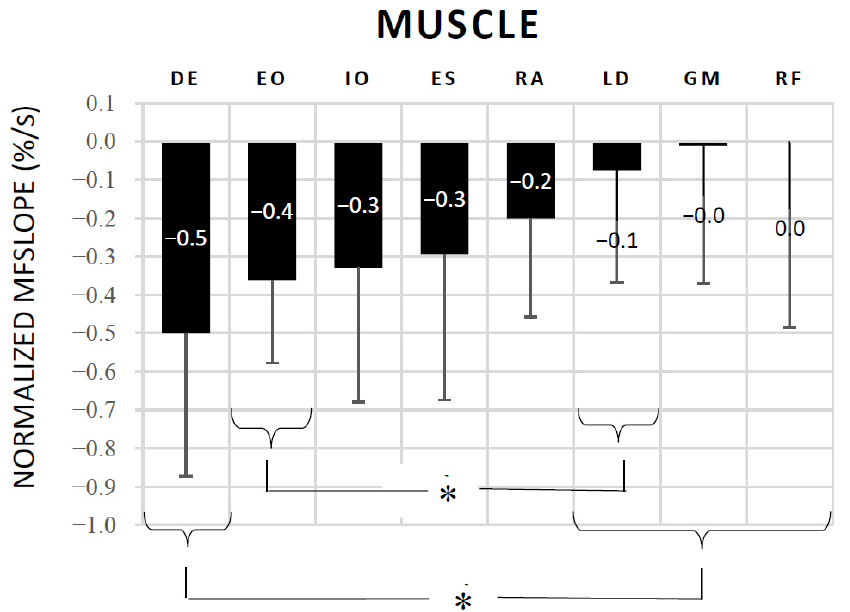
deviations. * Significant differences after post-hoc pairwise comparisons with Bonferroni correction ( p < 0.05).